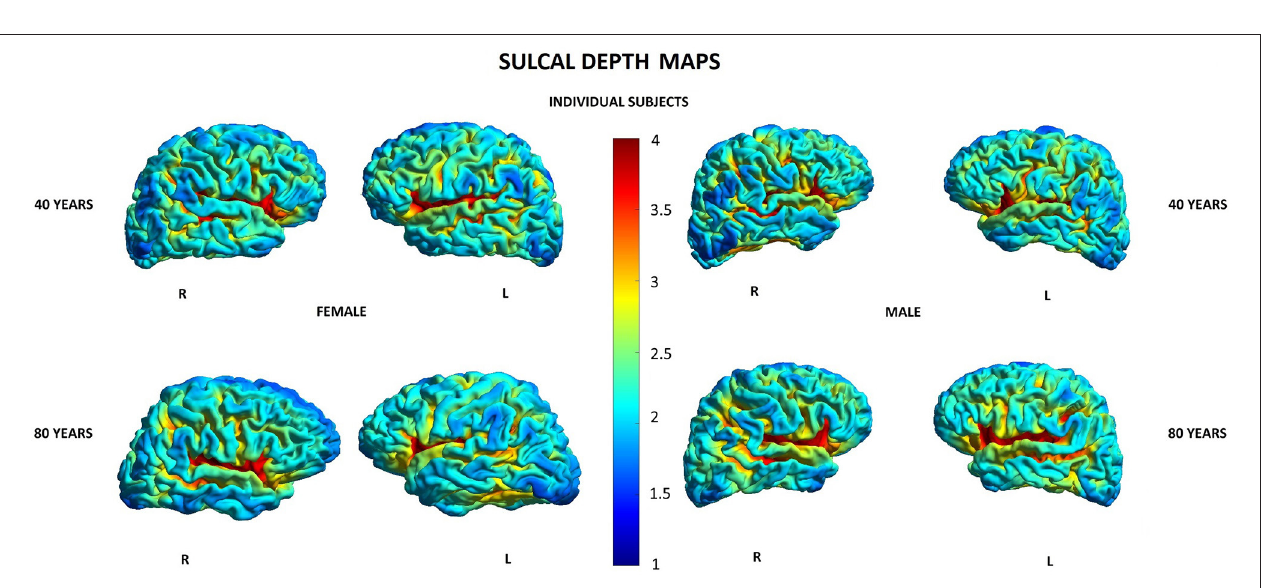
and left post-central sulcus ( Table 5 ). Figures 3 – 6 show 3D